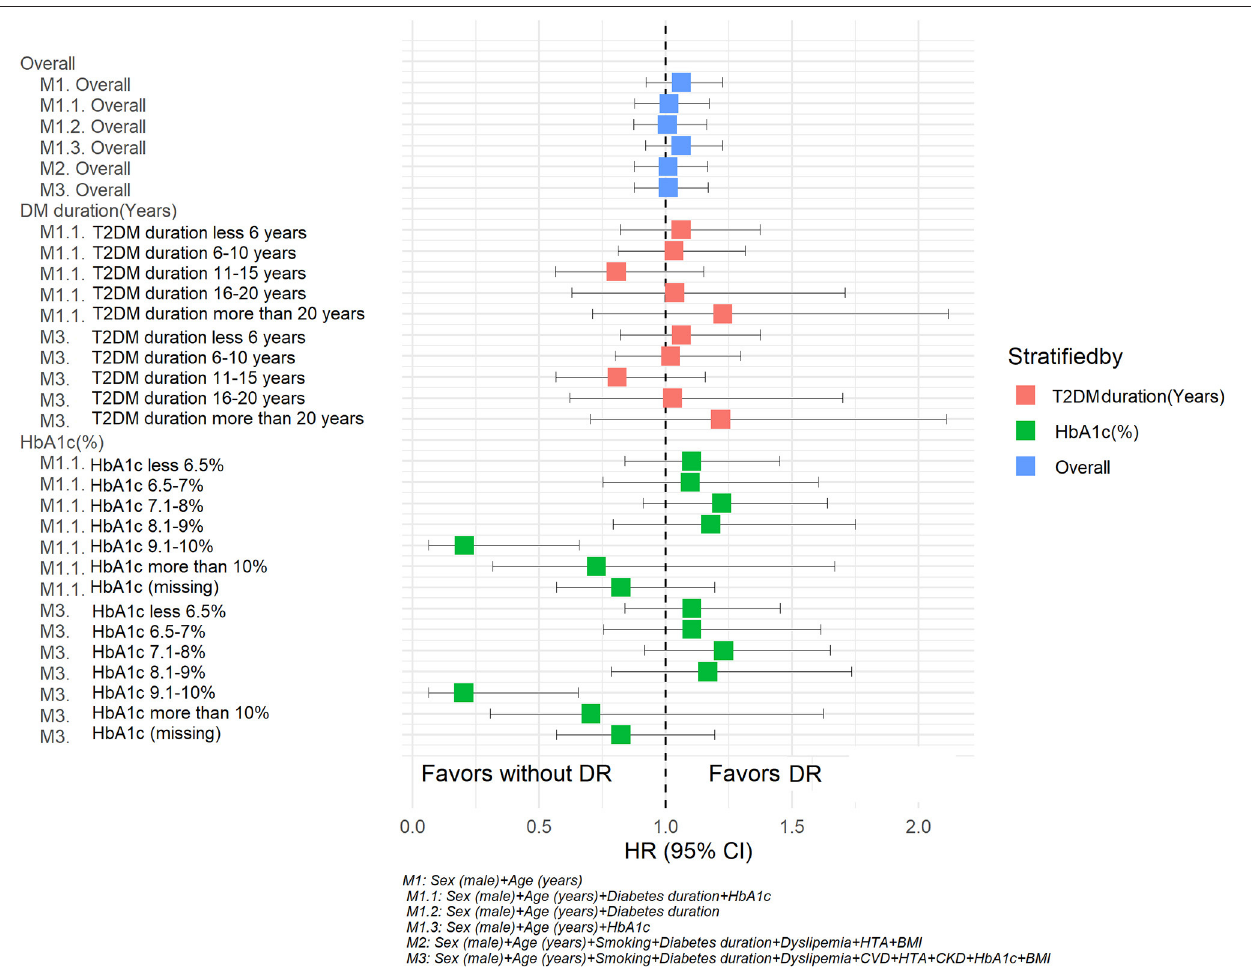
FIGURE 3 | Hazard ratios for Parkinson’s disease according retinopathy status. Sensitivity analysis. M1: Sex (male) + Age (years). M 1.1 Sex (male) + Age (years) + Diabetes duration + HbA1c. M1.2 Sex (male) + Age (years) + Diabetes duration. M1.3 Sex (male) + Age (years) + HbA1c. M2: Sex (male) + Age (years) + Smoking + Diabetes duration + Dyslipidemia + HTA + BMI. M3: Sex (male) + Age (years) + Smoking + Diabetes duration + Dyslipidemia + HTA + CKD + HbA1c +